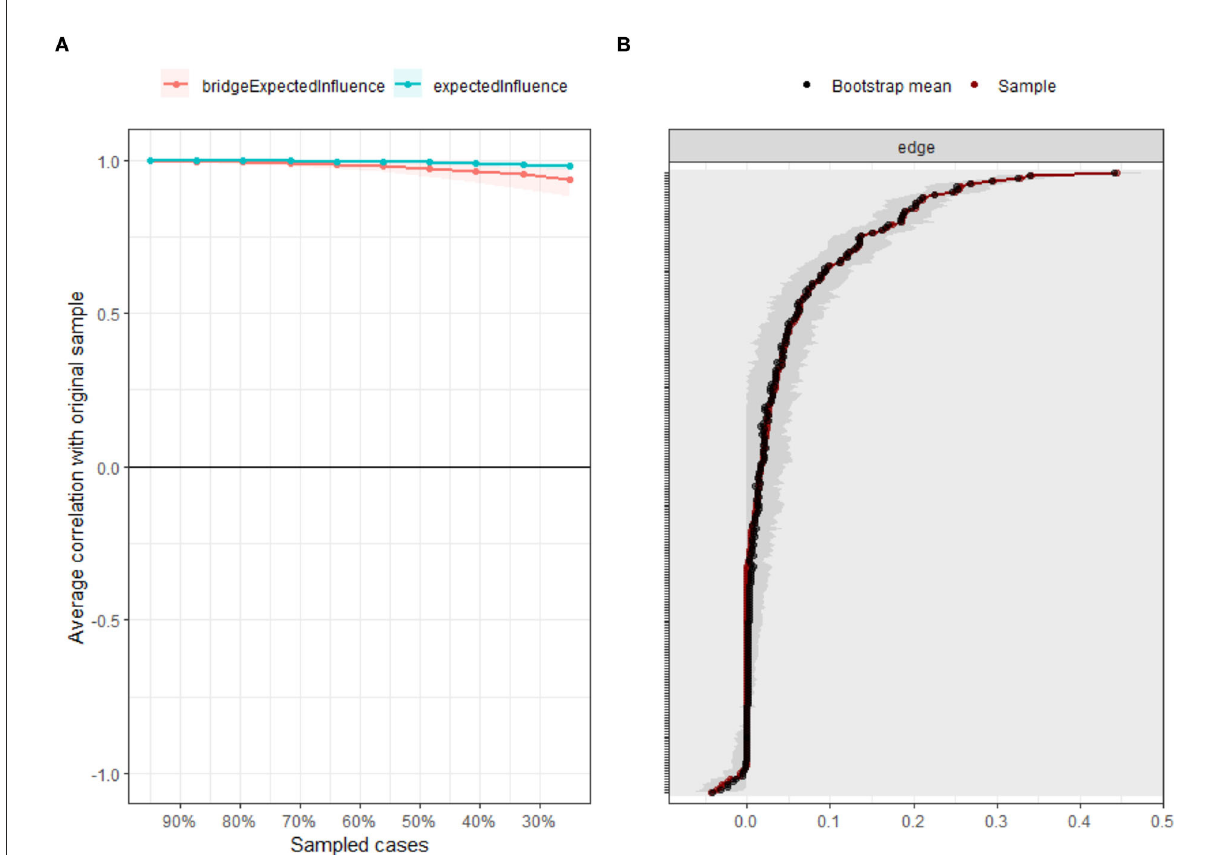
FIGURE3 Accuracy and stability of the network. (A) The stability of central and bridge expected influence by case-dropping bootstrap. (B) The accuracy of the network edges by non-parametric